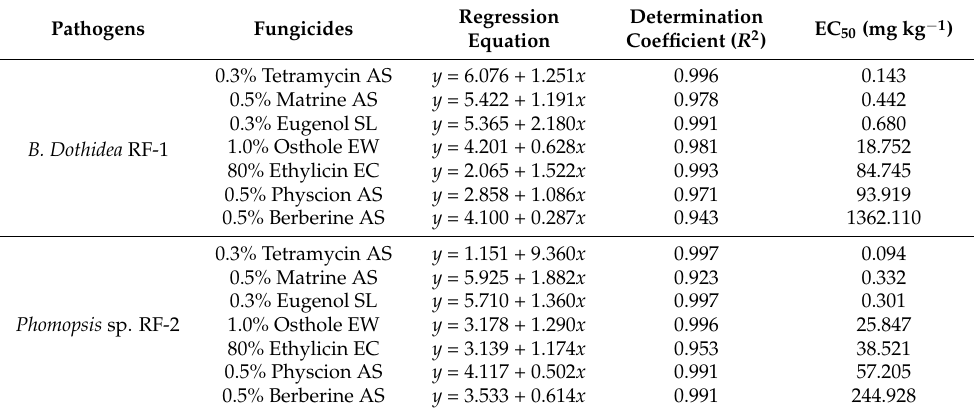
Table 3. Toxicities of tetramycin and botanical fungicides against B. dothidea and Phomopsis sp.